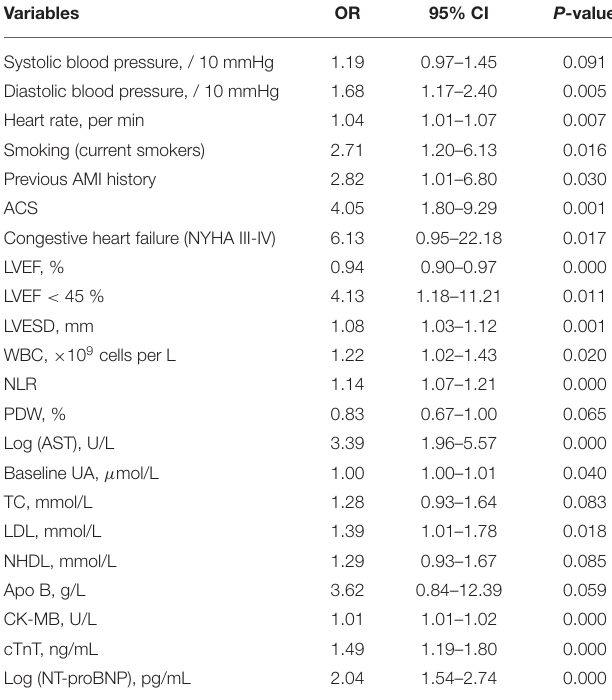
TABLE 2 | Univariate analysis in our cohort.